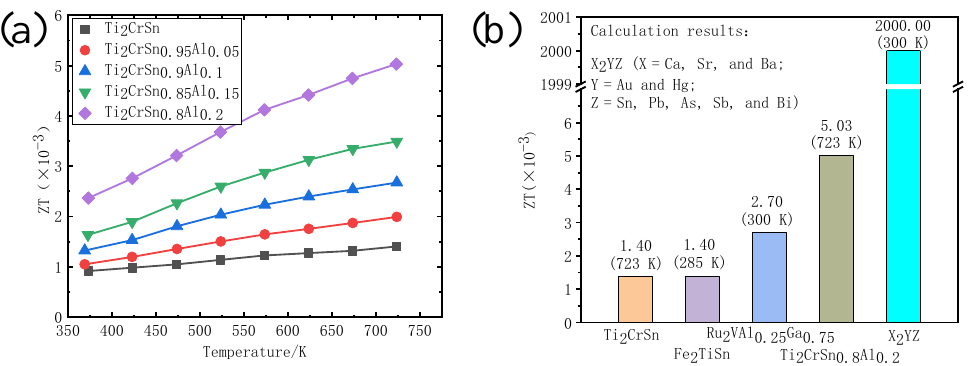
Figure 7. ( a ) Variation in the ZT values of the Ti 2 CrSn 1-x Alx (x = 0, 0.05, 0.1, 0.15, 0.2) alloy in response to temperature (x = 0, 0.05, 0.1, 0.15, 0.2). ( b ) Comparison of the dimensionless thermoelectric optimal ZT of the Ti 2 CrSn 1-x Al x (x = 0, 0.05, 0.1, 0.15, 0.2) alloy at the corresponding temperature with other reported full-Heusler alloys [29,34,35].